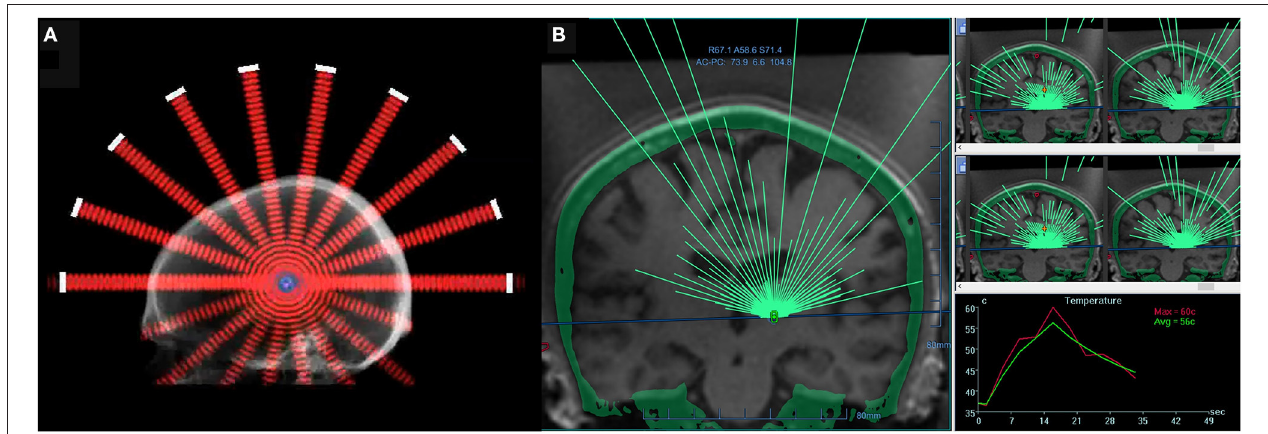
FIGURE 1 | (A) A 2-dimensional schematic of a hemispherical phased-array transducer, showing multiple beams converging at a geometric focus. (B) A screen image of a commercial software MRgFUS with > 1,000 individual transducer elements (ExAblate; InSightec, Israel). All transducer elements use a phase shift algorithm to account for individual skull effects. Transducer elements are individually electronically steered to ensure precise, submillimeter targeting. For the treatment of essential tremor, a typical device operates at approximately 650kHz, achieving a focal spot size of approximately 6mm and a target temperature of 55 ◦ C (right bottom panel: real-time temperature monitoring via MR thermometry), thus allowing for thermoablation of a deep-seated brain